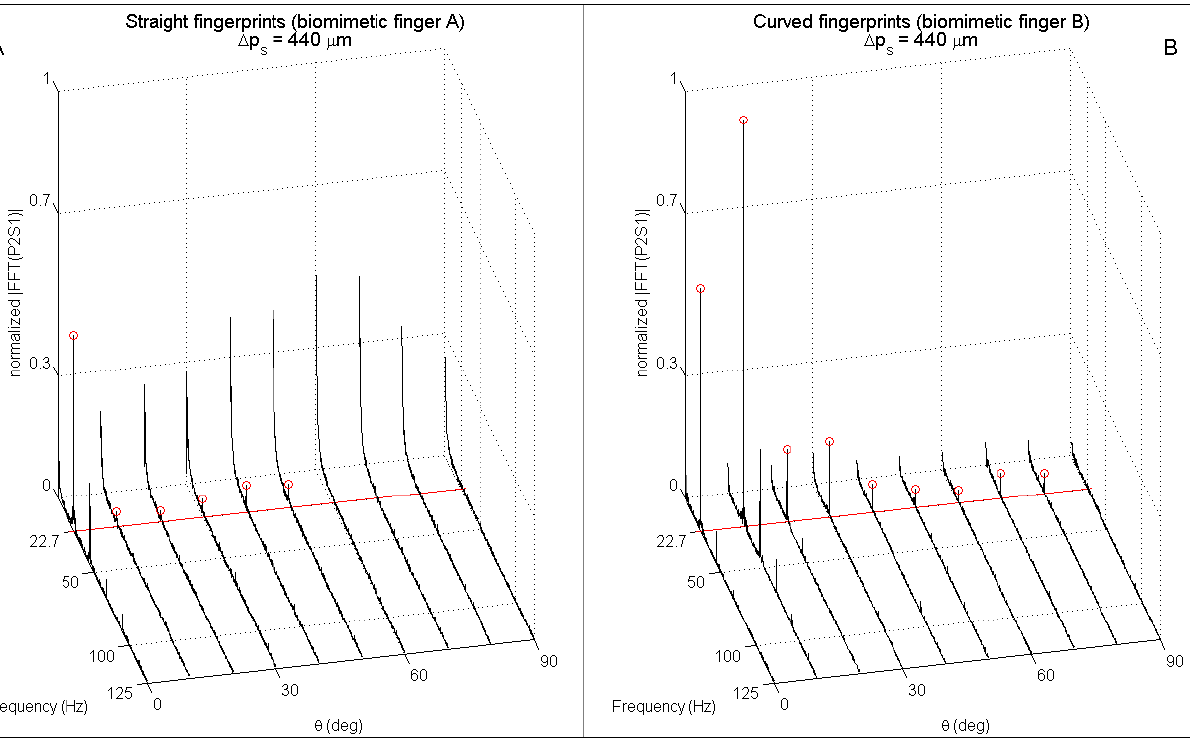
Figure 10. Single-sided normalized amplitude spectra as a function of the rotation of the biomimetic fingertip with straight ( Panel A ) and curved ( Panel B ) fingerprints. Data is related to 4.096 s subsets gathered from Piezoresistor 2 of Sensor 1 (P4S4) while the stimulus was indented and rubbed tangentially to the